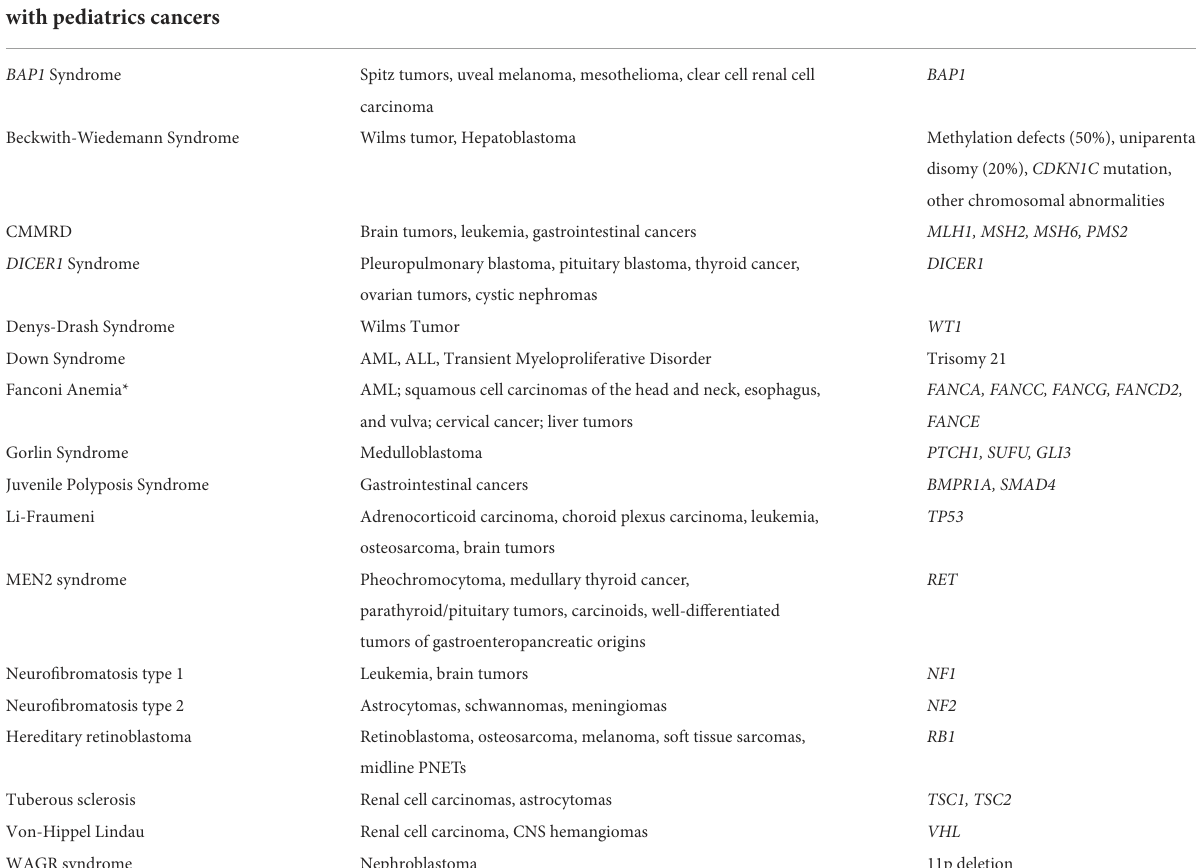
TABLE 1 Recognized syndromes associated with pediatrics tumors.